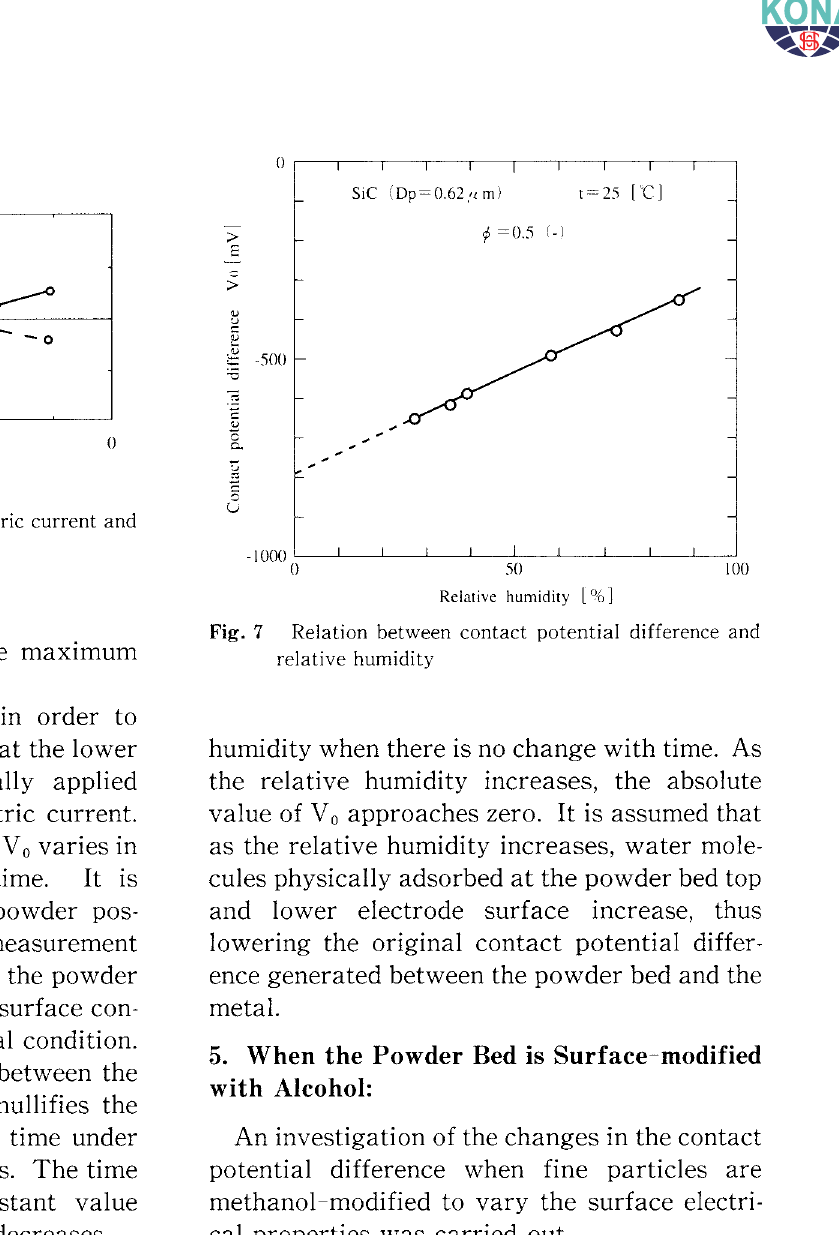
Fig. 5 Relation between amplitude of electric current and applied voltage